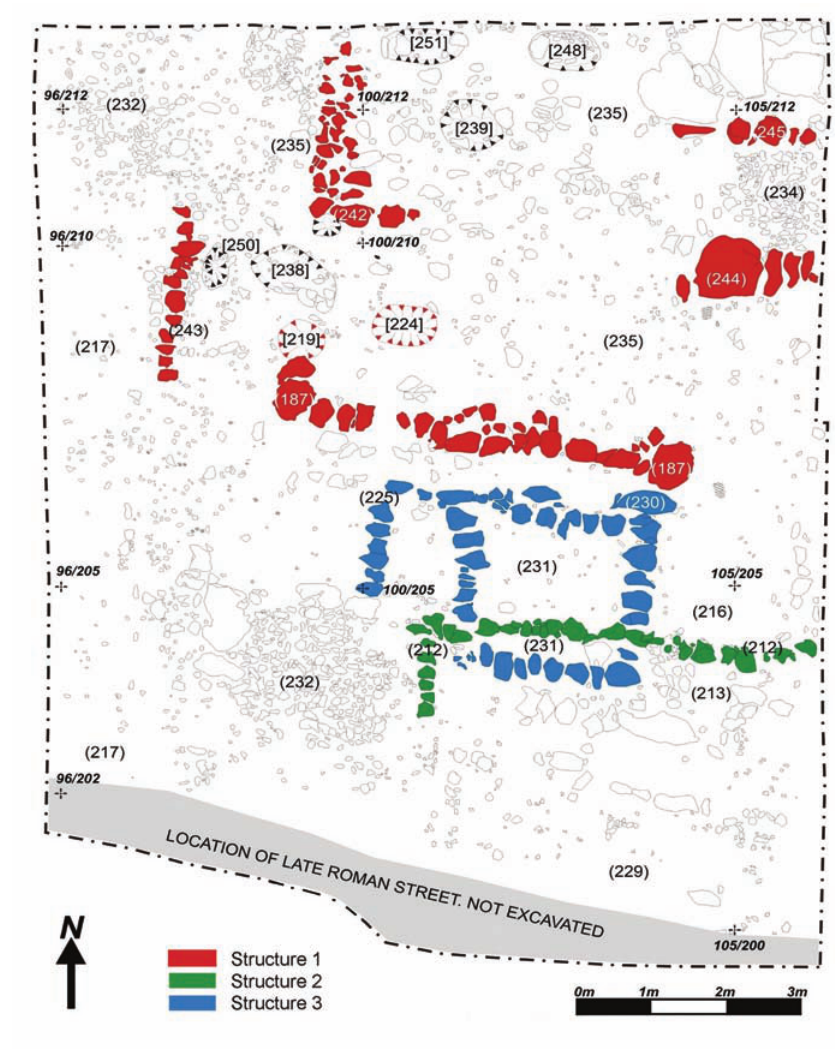
Figure 4 2008 Plan of Trench A showing structures and burial cuts (digitized by Dr Paul Everill)